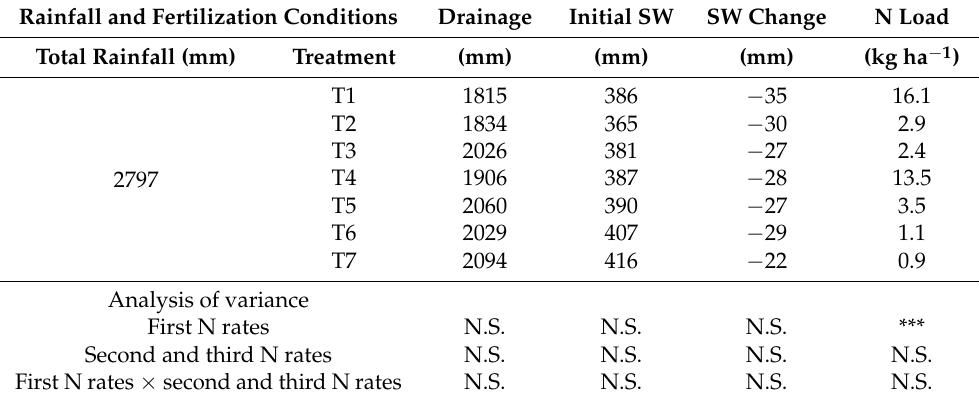
Table 5. Effects of reductions of the first, second, and third N fertilizer application rates on drainage, initial soil water at the beginning of the season (Initial SW), soil water change (SW change), and N load in season 3.